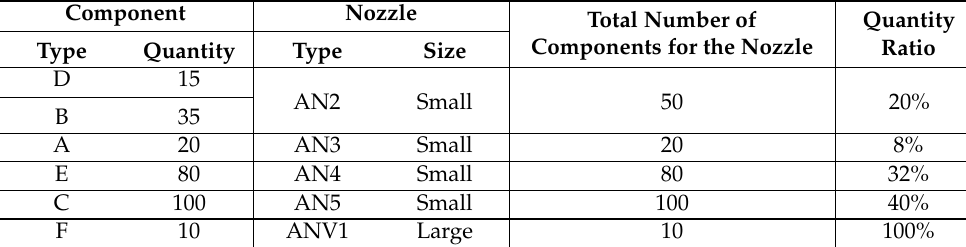
Table 2. The number of each type of